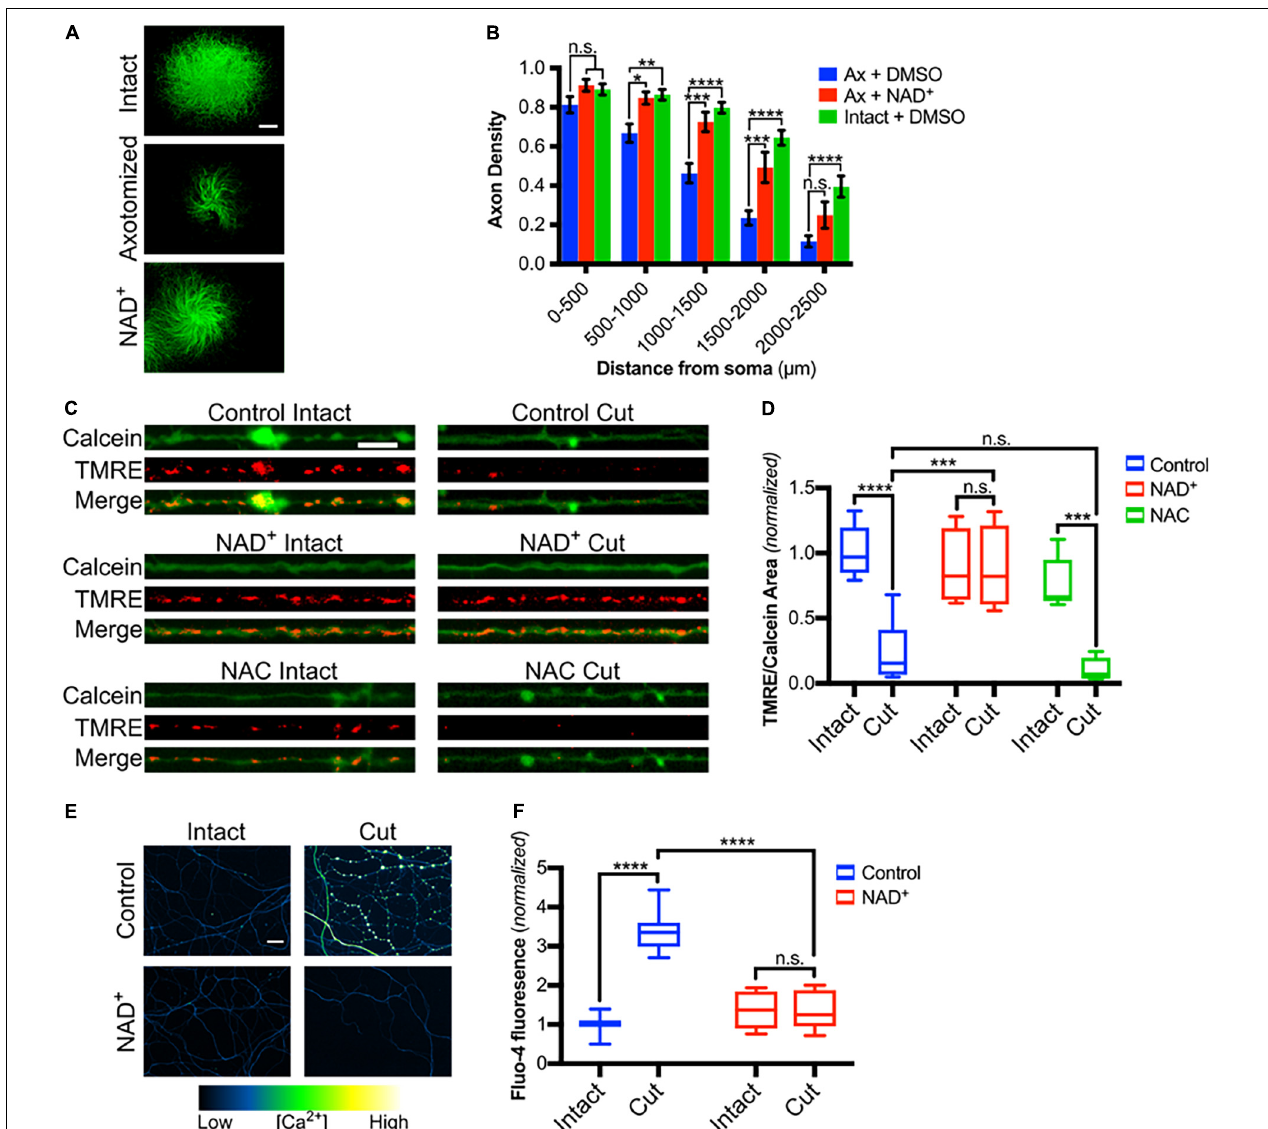
FIGURE 4 | Mitochondrial depolarization induced by axotomy is dependent on loss of NAD + but not on ROS accumulation. (A) Intact or cut DRG axons treated with NAD + (5 mM-30 min treatment) and immunostained for β -III tubulin (scale bar indicates 1,000 µ m). (B) Axon density of intact or axotomized (Ax) DRGs in radial bins of increasing distance from the center ( n = 7 for each group). Values are mean ± SEM. Statistical significance was assessed using a two-factor ANOVA followed by Dunnett’s test relative to Ax + DMSO. (C) Intact or cut axons treated with either NAD + (5 mM) or NAC (20 mM), loaded with Calcein-AM and TMRE (scale bar indicates 10 µ m) and imaged 3.5 h after axotomy. (D) Mitochondrial polarization readout calculated as TMRE-positive area divided by Calcein-positive area and normalized to intact control [ n = 10 (control), 5 (NAC), 4 (NAD + )]. Boxplots are minimum, 1st quartile, median, 3rd quartile, maximum. Statistical significance was assessed using a two-factor ANOVA followed by Tukey’s post hoc comparison. (E) Micrographs of intact or cut axons treated with NAD + (5 mM) and loaded with Fluo-4-AM (scale bar indicates 25 µ m). (F) Fluo-4-AM intensity in axons, normalized to intensity of intact controls [ n = 10 (control), 7 (NAD + )]. Boxplots are